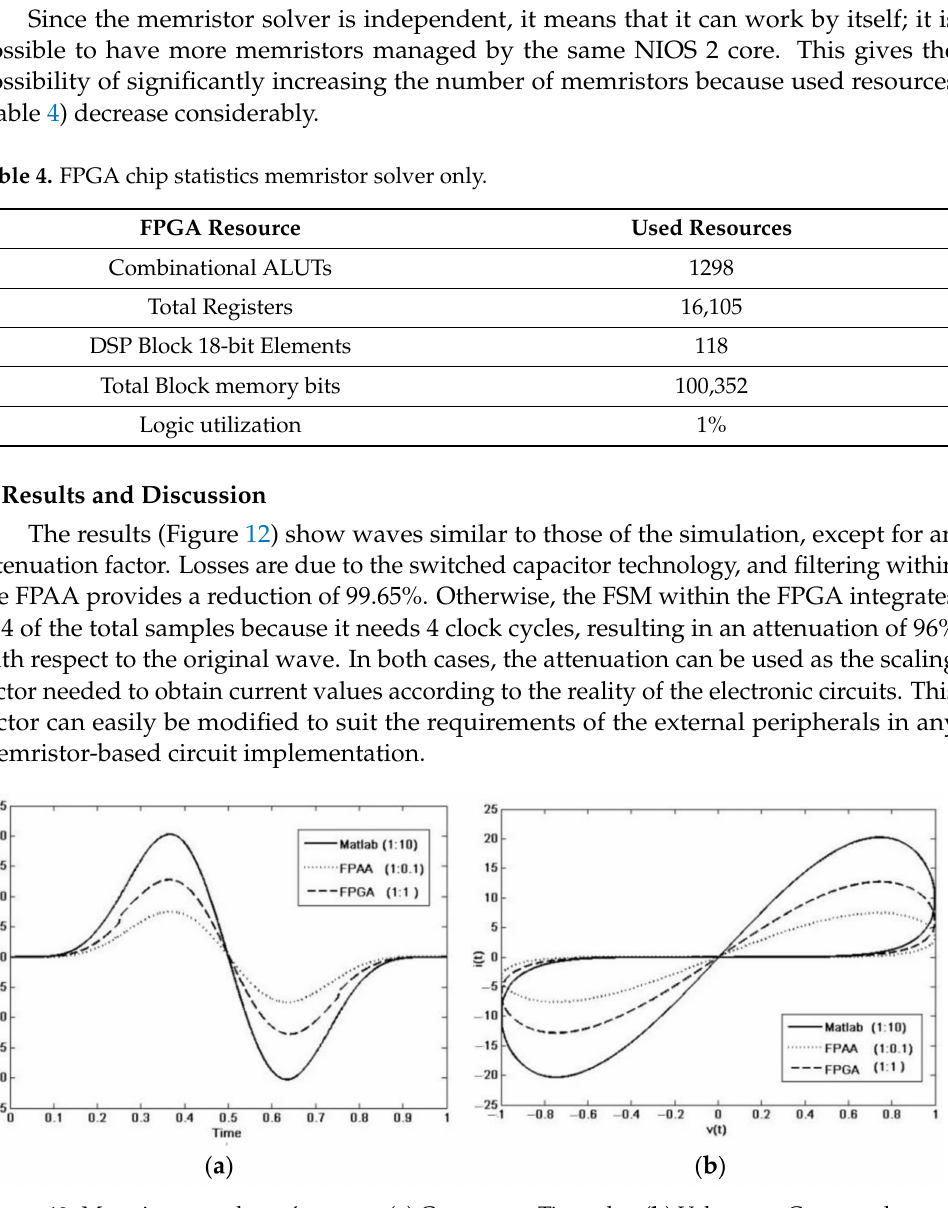
Figure 12. Memristor emulators’ current: ( a ) Current vs. Time plot; ( b ) Voltagevs. Current plot. The time for one integration step depends on the main clock frequency on the FPAA, and on the sampling clock on FPGA at 4 MHz and 2 MHz, respectively (Table